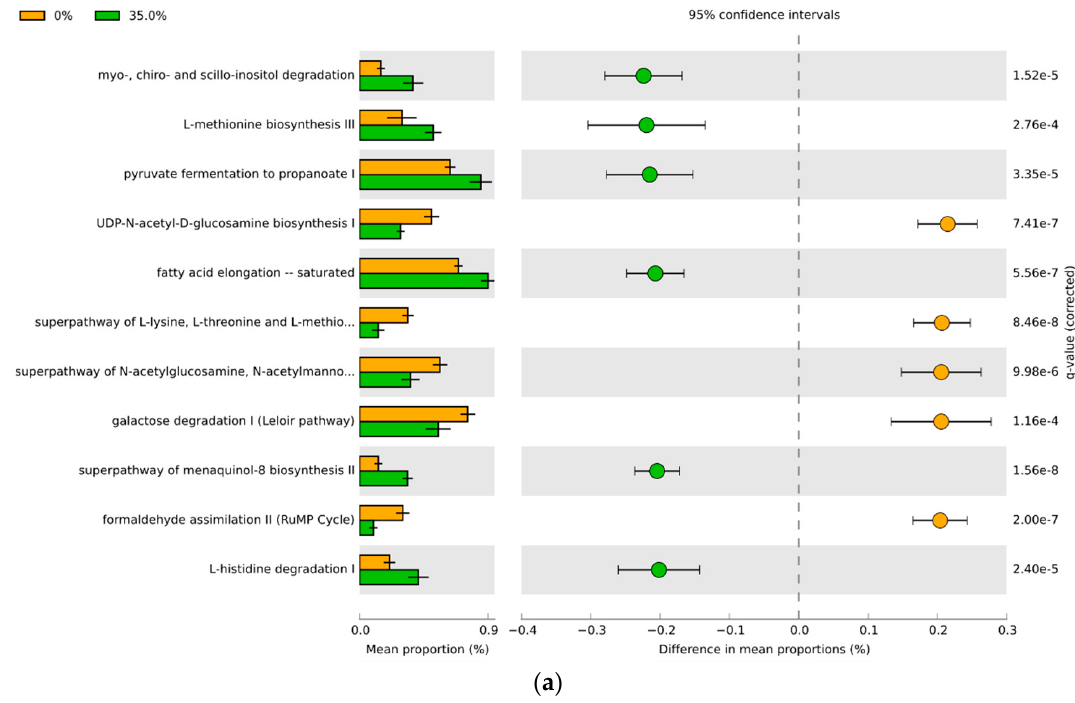
Figure 8. PICRUSt2 results indicating differential predicted functional pathways with 20% of the difference in the mean proportions between the bean-free and the bean-containing diet groups in the female cohort: bean-free diet (0%) is indicated in beige, while bean-based diet samples ( a –17.5%; b –35%, and c –70%)—in green. Extended error bar plot indicating the mean proportion of pathways assigned to each group, difference between them, and corrected p -value ( q -value) of